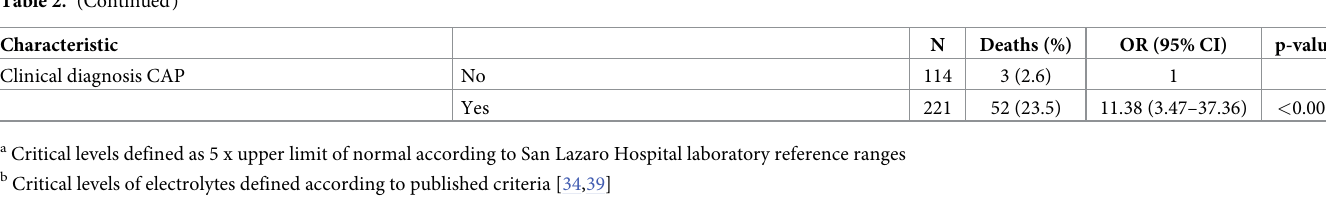
death (OR = 9.67 95% CI 2.48–37.76, p < 0.001) compared to non-anaemic or mildly anaemic patients. Positive HIV status or missing HIV status (due to lack of consent, often in older patients) and final clinical diagnosis of CAP also had independently increased odds of mortal- ity (Table 3). Due to reduced numbers of observations, hyperphosphataemia was not included in main multivariable analysis, but when included in the same model as reported above (N = 281) was independently associated with increased odds of mortality (OR = 3.74; 95% CI 1.20–11.62; p = 0.023) whilst not appreciably changing the effect estimates of the other inde- pendent exposure variables (S3 Table).